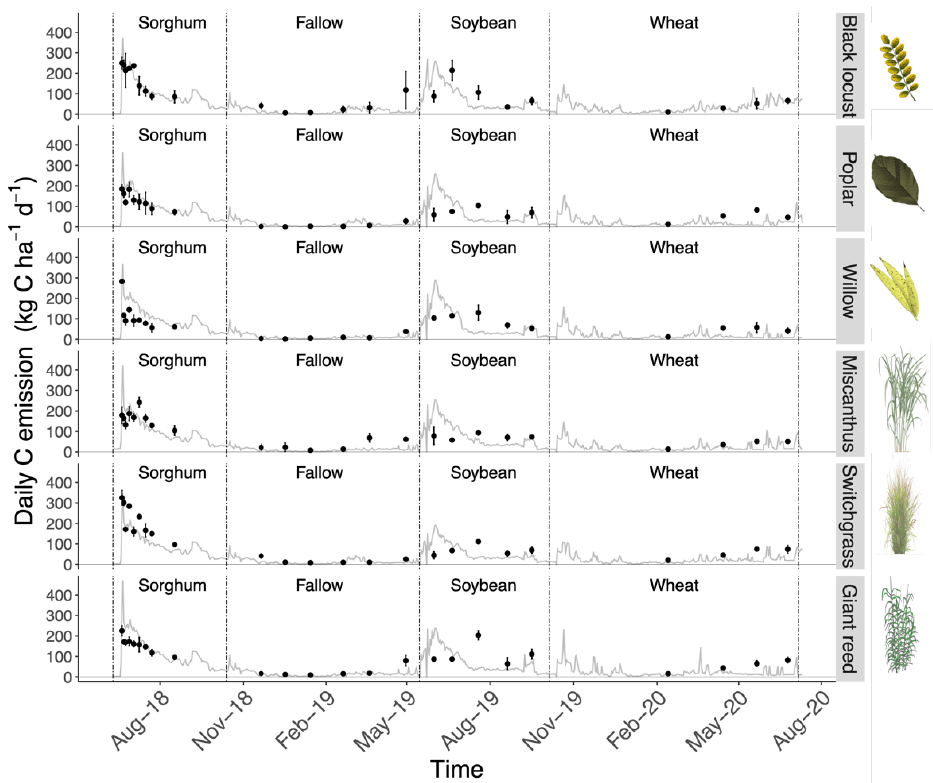
Figure 1. Results of the 2-year (2018–2020) ECOSSE simulation of C emission from soil (measured as CO 2 ) after the reversion of six different perennial energy crops to annual crops. The gray line represents modeled C emission, while the black dots represent measured values. Mean measured C emissions with error bars indicate 95% confidence intervals.